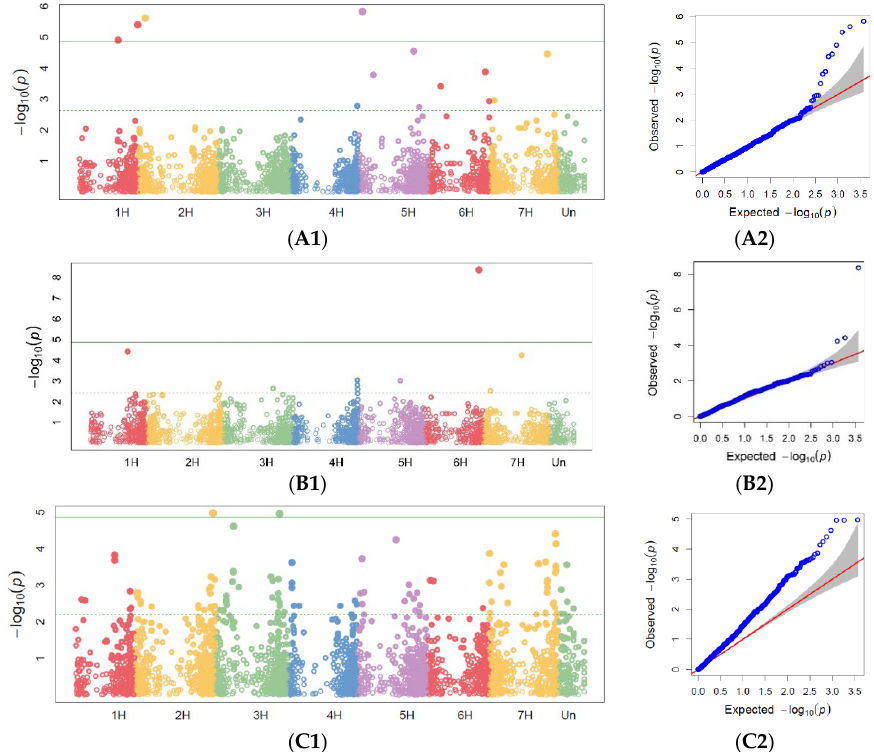
Figure 13. Single-nucleotide polymorphism (SNP) significantly associated with barley brown rust (BBR) resistance in barley identified by genome-wide association study (GWAS) with BLINK model. Manhattan plot and quantile–quantile plot for 2019 heading stage Figures ( A1 ) and ( A2 ); Manhat- tan plot and quantile–quantile plot for 2019 milky-waxy stage Figures ( B1 ) and ( B2 ); Manhattan plot and quantile–quantile plot for maximum disease scores across both growth stages and years Figures ( C1 ) and ( C2